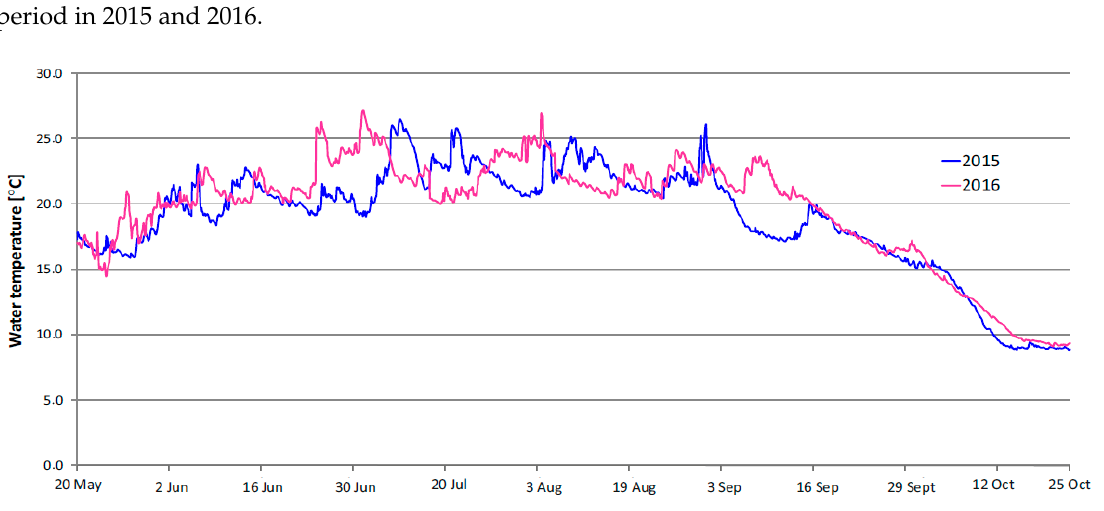
Figure 5. Profile of water temperature changes in the northern part of the Sulejow Reservoir